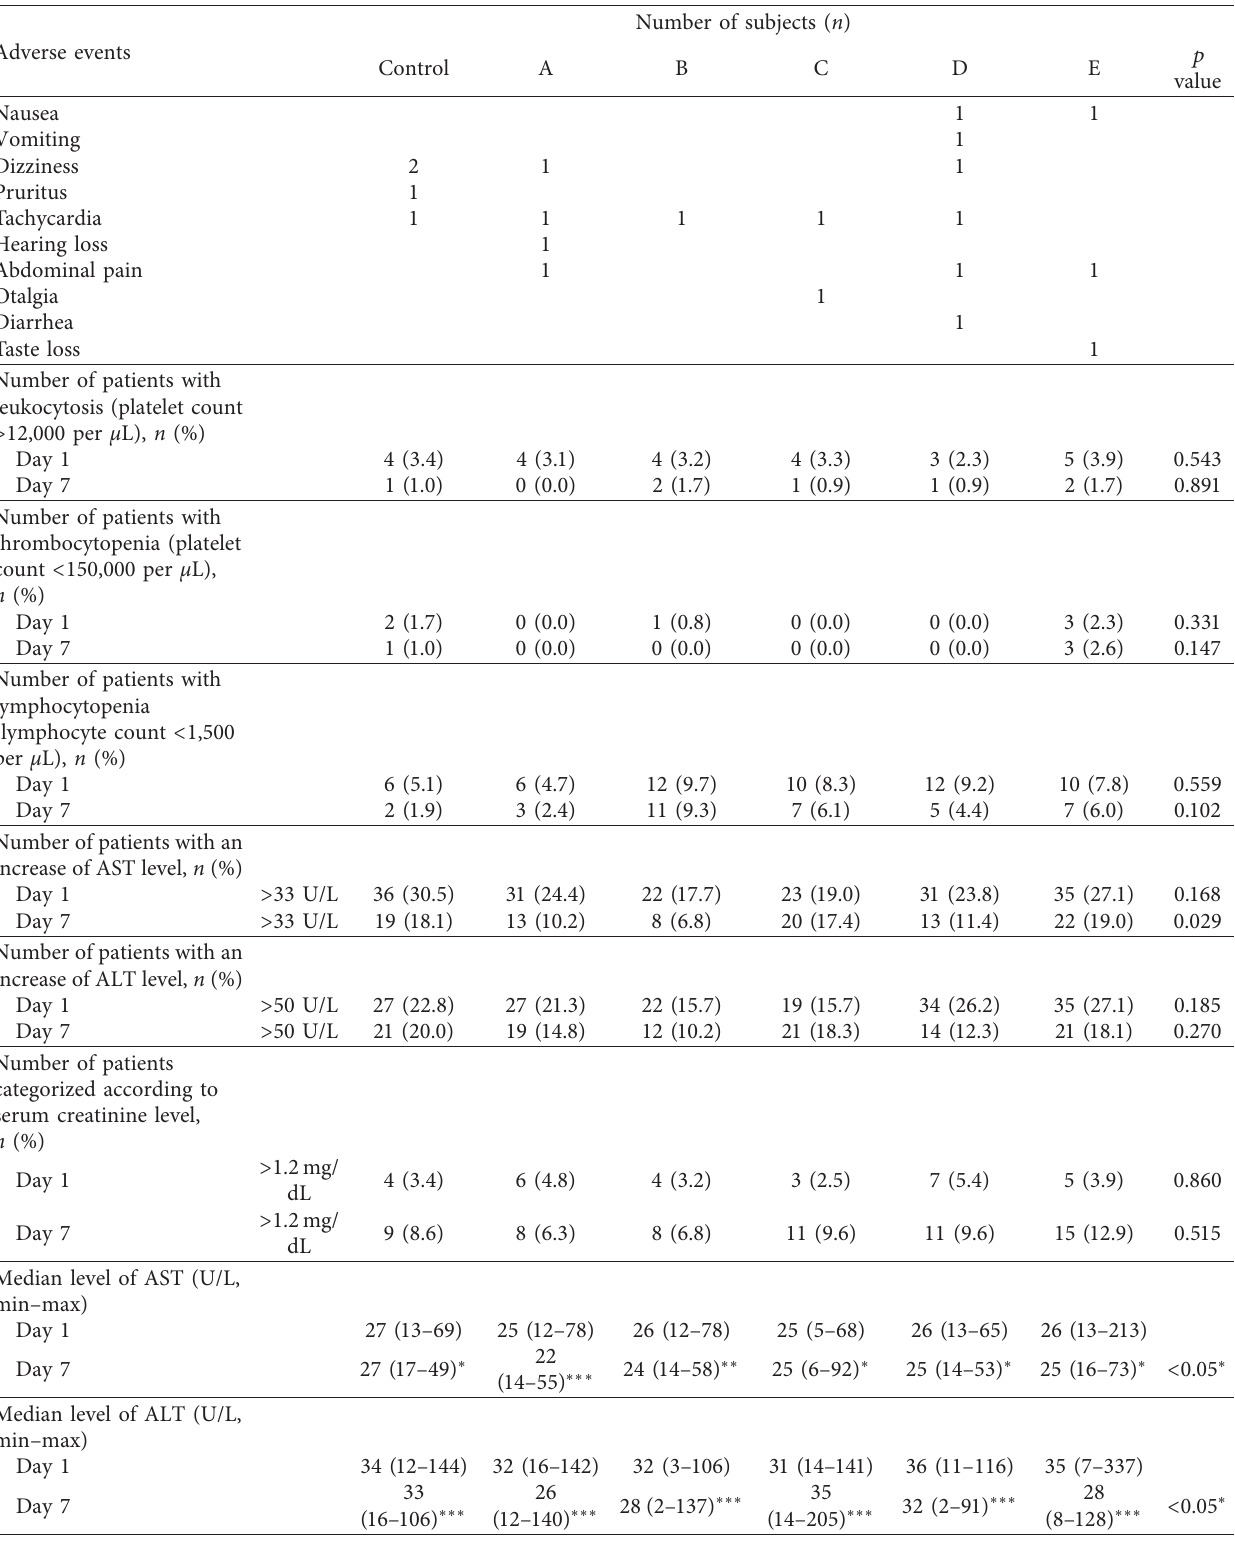
Table 4: The adverse events observed in the research subjects during the study